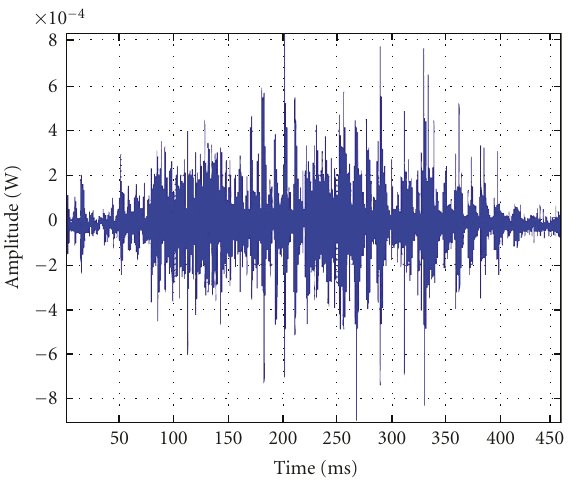
Figure 5: Vocal signal amplitude versus frequency (TEP3).